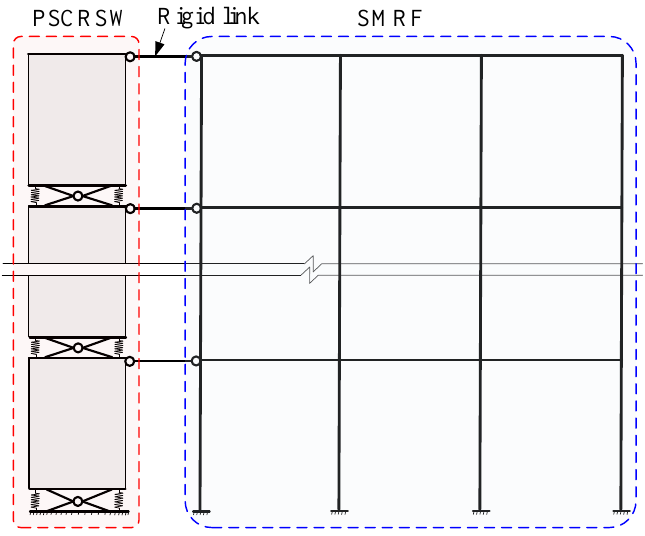
Figure 11. Enhancing strategy for SMRF. Specify the performance objectives and the corresponding inter-story drift ratio (ISDR) targets, which are denoted as θ y , θ d and θ u for service level earthquake (SLE), design-based earthquake (DBE) and maximum considered earthquake (MCE), re- spectively.